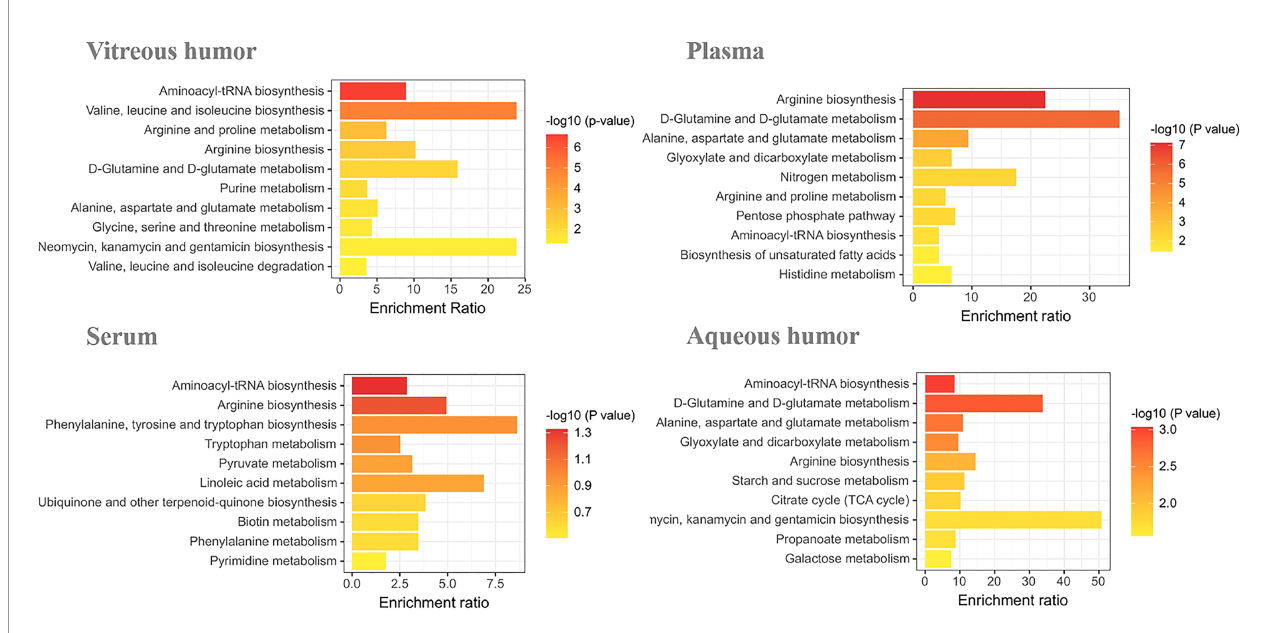
FIGURE 1 | Enrichment analysis of DR potential biomarkers in vitreous humor, plasma, serum, and aqueous